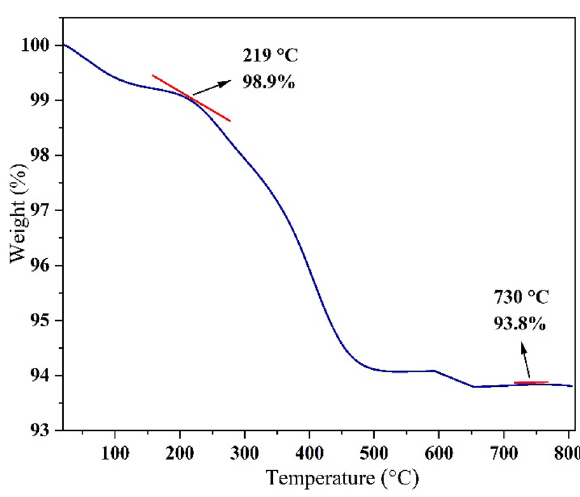
Figure 7. TGA of (γ-Fe 2 O 3 -Im-Py) 2 WO 4 .